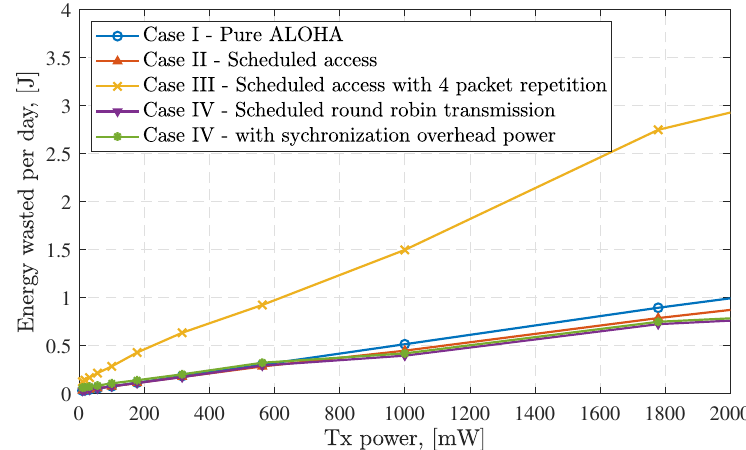
Figure 14. Illustration of the energy wasted as a function of the transmit power for the different access methods. The maximum number of transmissions is set to two messages per day with a size 12 bytes payload.